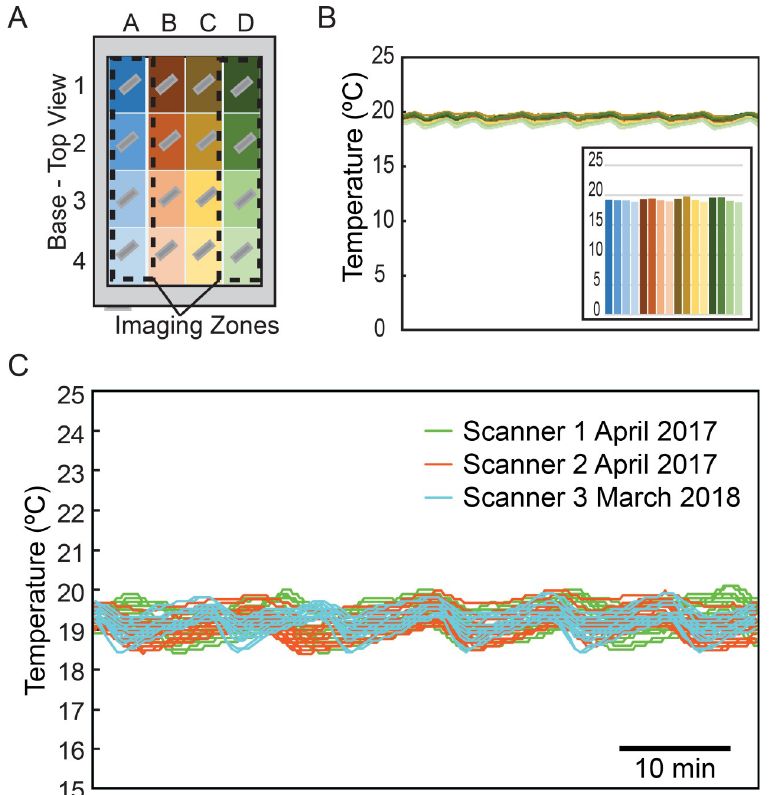
Fig 3. Scanner temperature stability. (A) Temperature probes were mounted on glass slides as PDMS chips are and arrayed to cover the entire surface of the scanner. The outermost columns of probes lie in the imaging zone where microfluidic chips would be mounted. (B) Temperature data from a mock run shows little variability in temperature over time. The cycling of temperature that is observed corresponds to HVAC cycling in the temperature-controlled room not with the imaging cycle of the scanner. (C) Measurements on different scanners on different days are